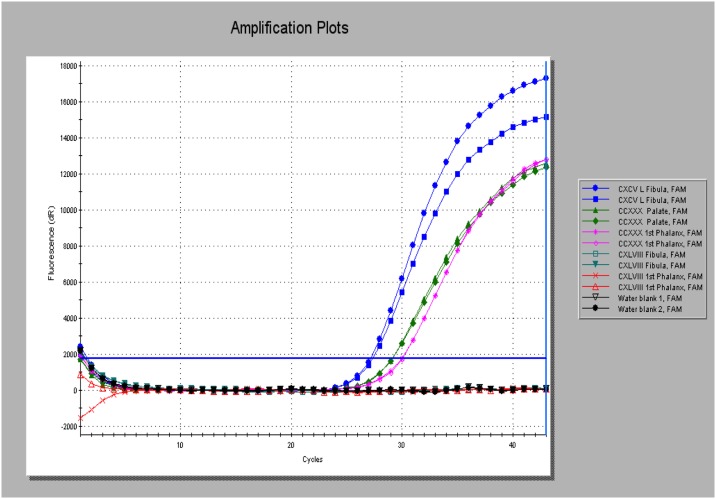
Amplification plots of the multi-copy PCR target RLEP reported with a specific FAM-labelled fluorogenic probe.Products were generated from extracts prepared from SkCXCV (left fibula, blue traces) and SkCCXXX from two extracts (palate, green traces) and first phalanx (fuchsia pink trace). SkCXLVIII was negative using this PCR method, as were the two template blanks run in parallel (black traces).